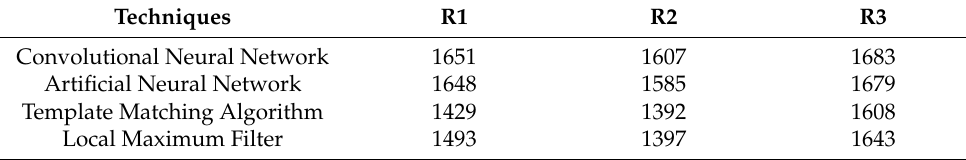
Table 6. Accuracy of different algorithms to detect count of palm